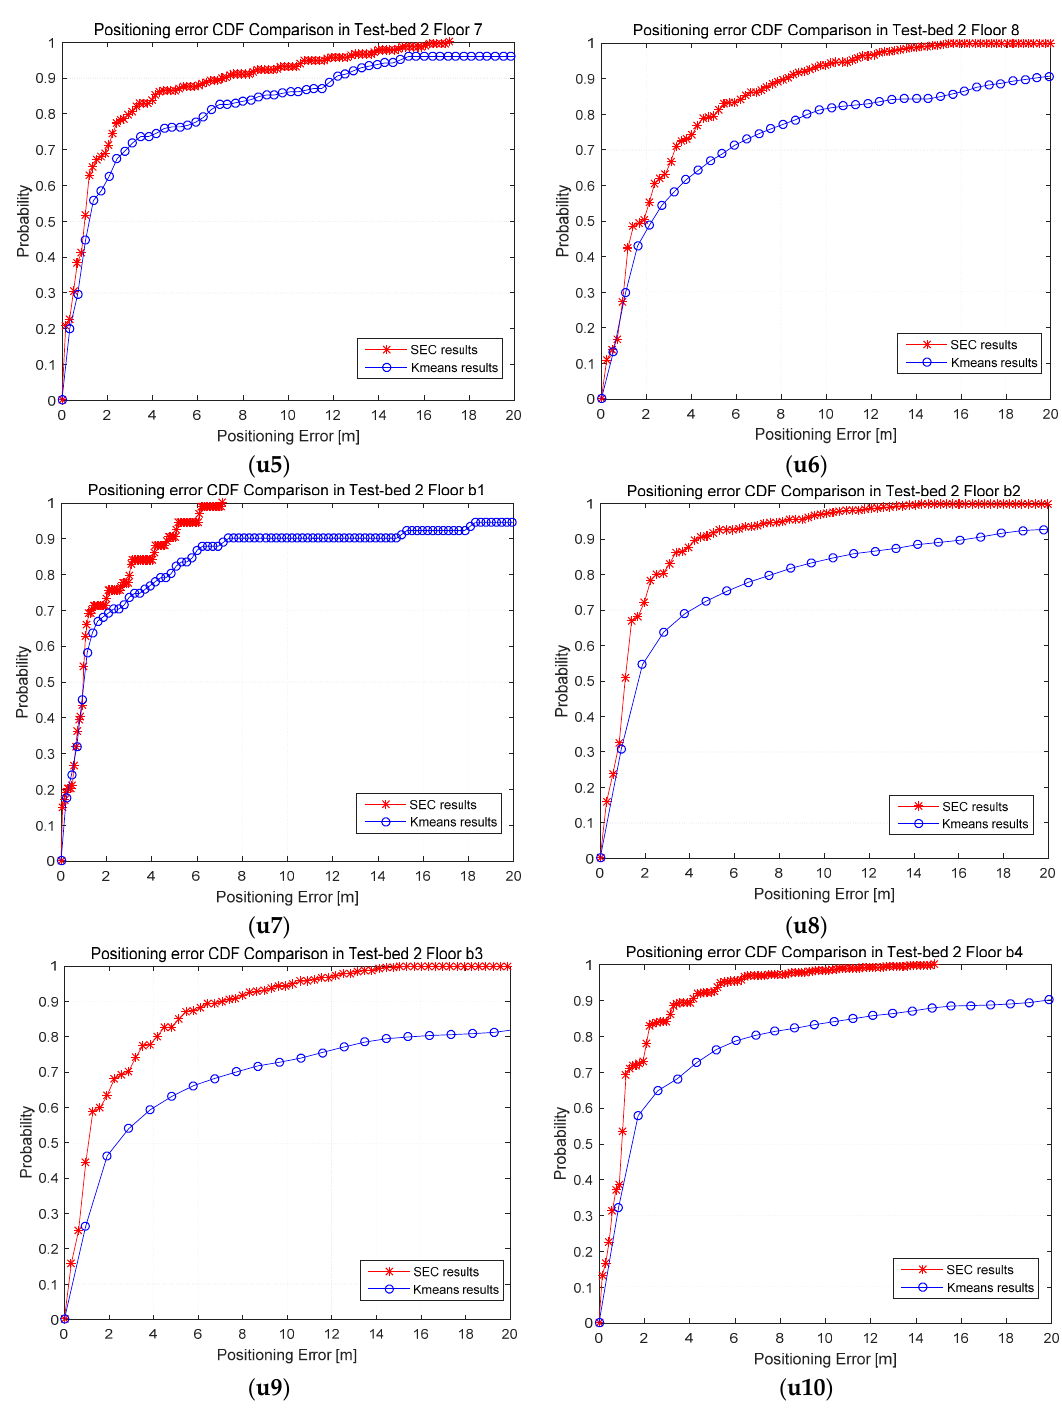
Figure A1. Clustering results and positioning performance comparisons for Test-bed 2: ( a – t ) the clustering results and comparisons between K-means and SEC from Floor 3 to Floor b4 in Test-bed 2; and ( u1 – u10 ) the positioning performance comparisons between K-means and SEC from Floor 3 to Floor b4 in Test-bed 2.